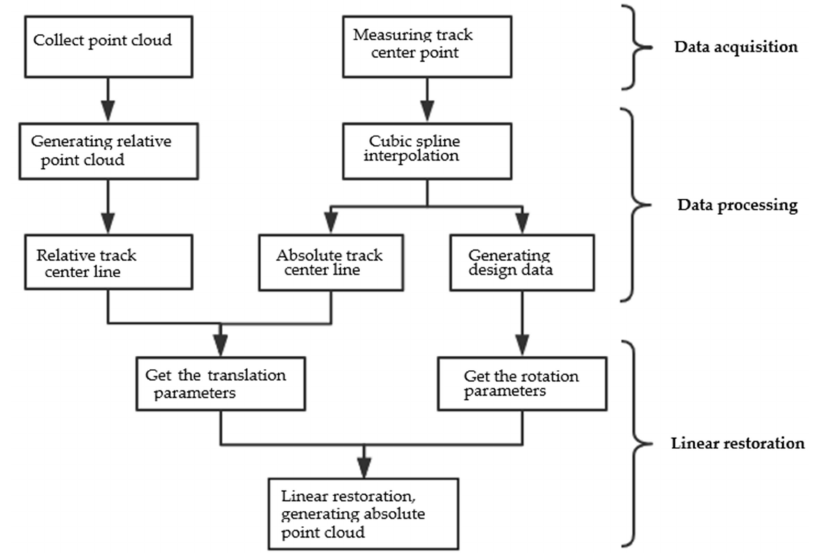
Figure 2. Flow chart of restoration of the measured centerline